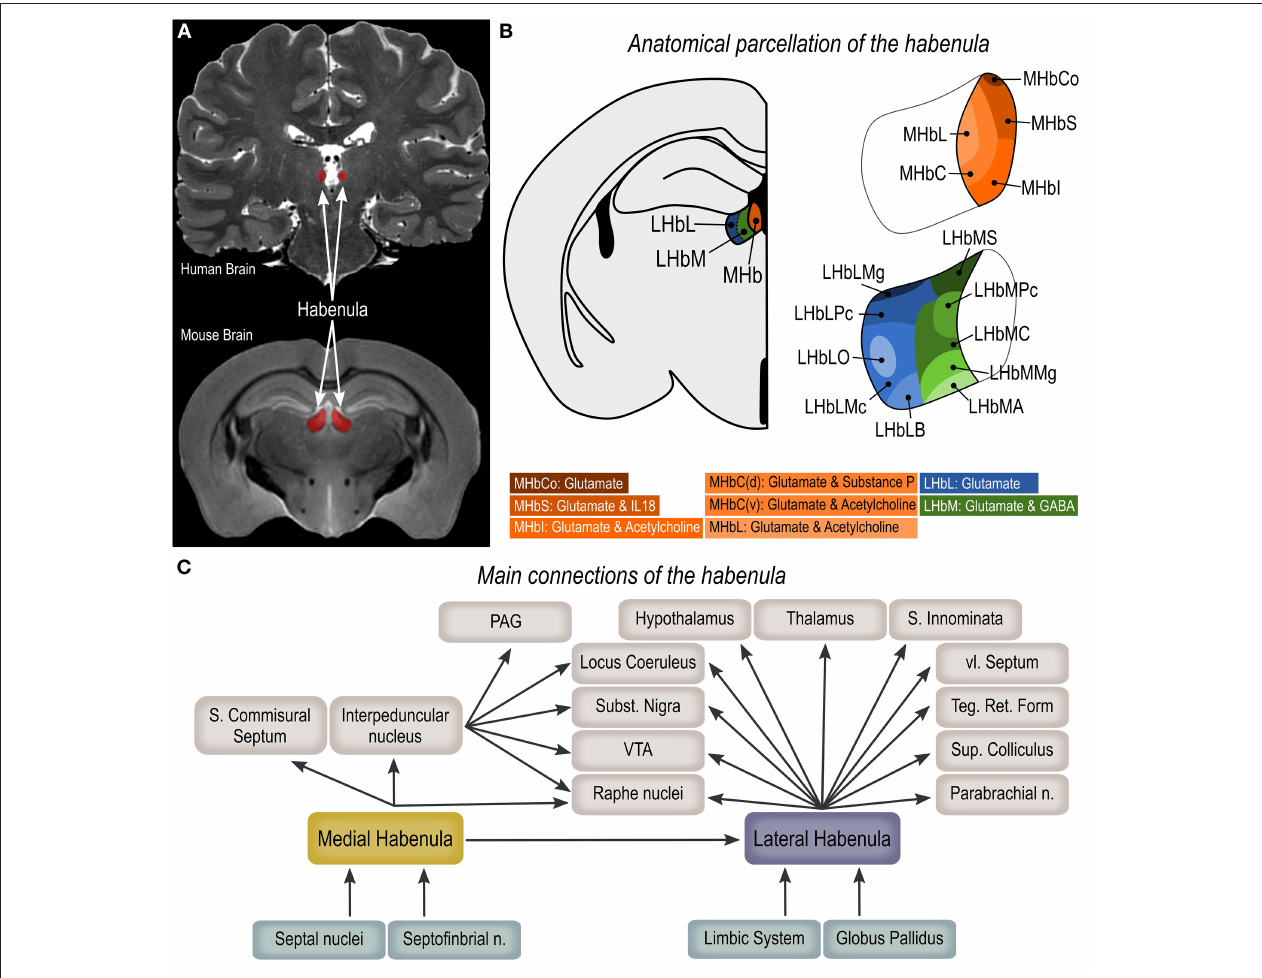
FIGURE 1 | Anatomical organization of the habenula. (A) Magnetic resonance imaging (coronal plane) showing the human and mouse habenula (https://openneuro. org/datasets/ds002179/versions/1.1.0). (B) Anatomical parcellation of the medial (MHb) and lateral habenula (LHb). (C) Main habenula connections. MHbS, medial habenula superior part; MHbI, medial habenula inferior part; MHbC, medial habenula central part; MHbL, medial habenula lateral part; MHbCo, medial habenula commissural part; LHbMA, lateral habenula medial part anterior subregion; LHbMS, lateral habenula medial part superior subregion; LHbMPc, lateral habenula medial part parvocellular subregion; LHbMC, lateral habenula medial part central subregion; LHbMMg, lateral habenula medial part marginal subregion; LHbLPc, lateral habenula lateral part parvocellular subregion; LHbLMc, lateral habenula lateral part magnocellular subregion; LHbLO, lateral habenula lateral part oval